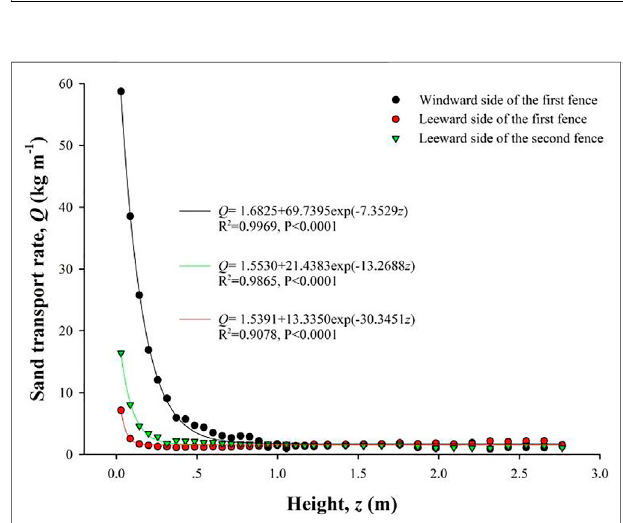
Frontiers in Environmental Science |